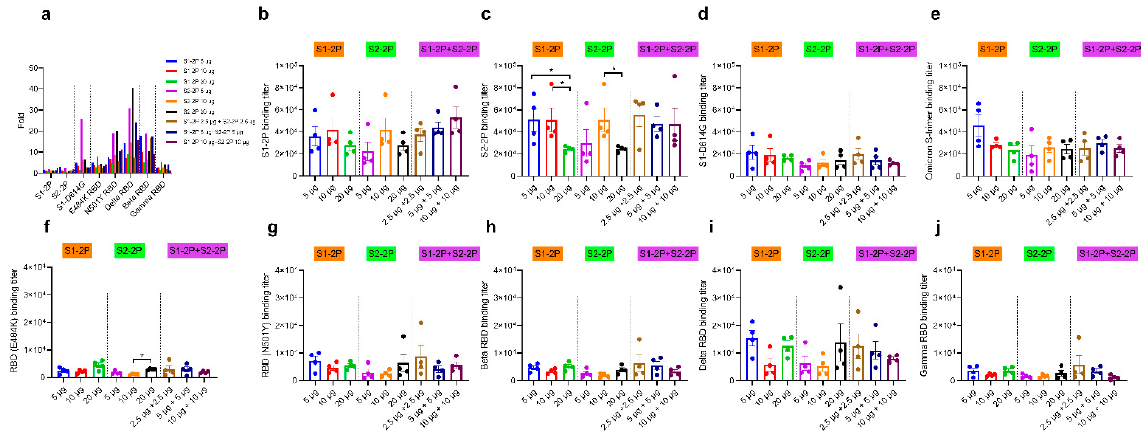
> 1 × 10 4 ), and 5 μ g S1-2P immunization elicited the highest antibody titer (EC 50 > 4 × 10 4 ). As for cross-binding antibody titers to different RBD proteins, the 20 μ g S2-2P group in- duced significantly higher E484K RBD binding titer than that of the 10 μ g dose group ( p < 0.05), while the differences in antibody titers to other RBD proteins within a group or between different immune groups were not significant. Especially, the RBD-specific anti- body titers elicited by the 2.5 μ g S1-2P and 2.5 μ g S2-2P bivalent vaccine groups were not inferior to other groups, indicating a low dose could work for a boost immunization.